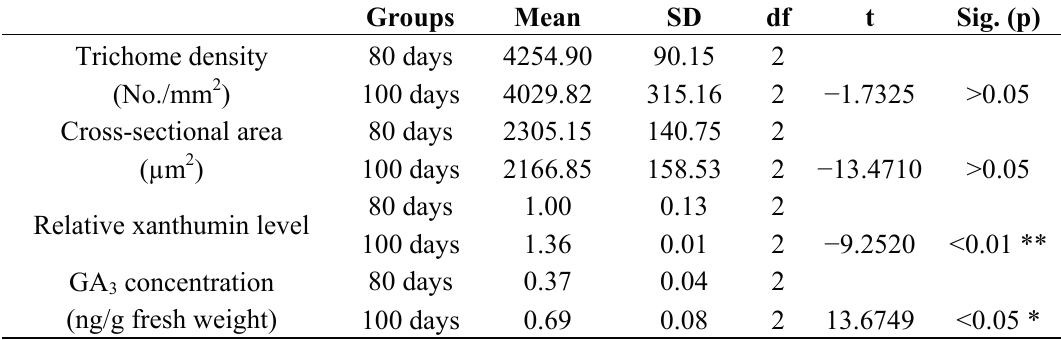
Table 1. The effect of flowering initiation on the gland formation, xanthumin production and endogenous GA biosynthesis in young X. strumarium L. leaves. Bars are 3